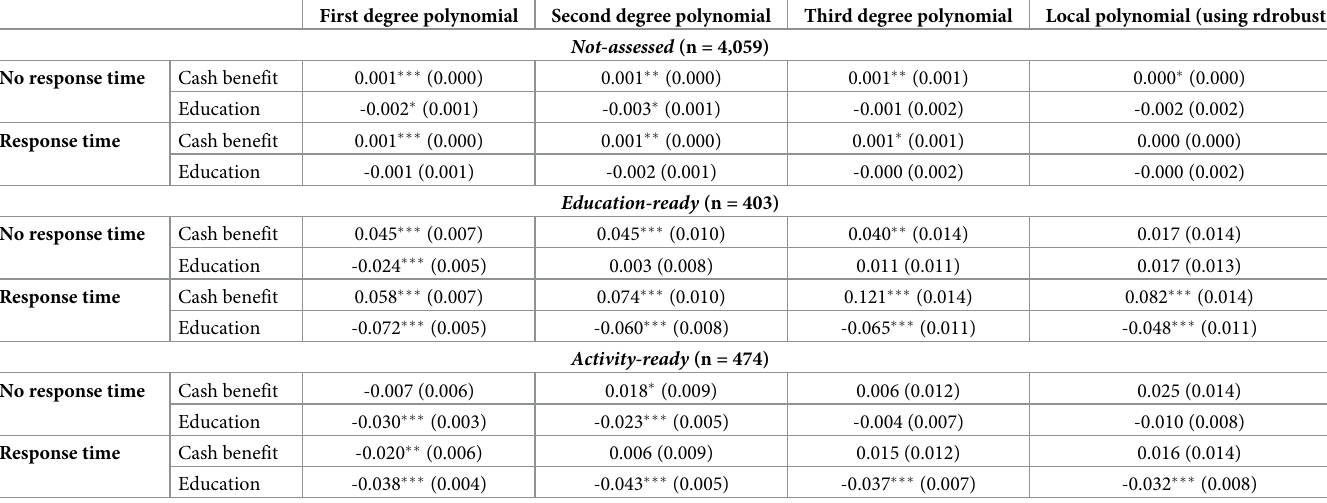
Table 5. RD estimates for young adults with low educational qualifications, by assessment